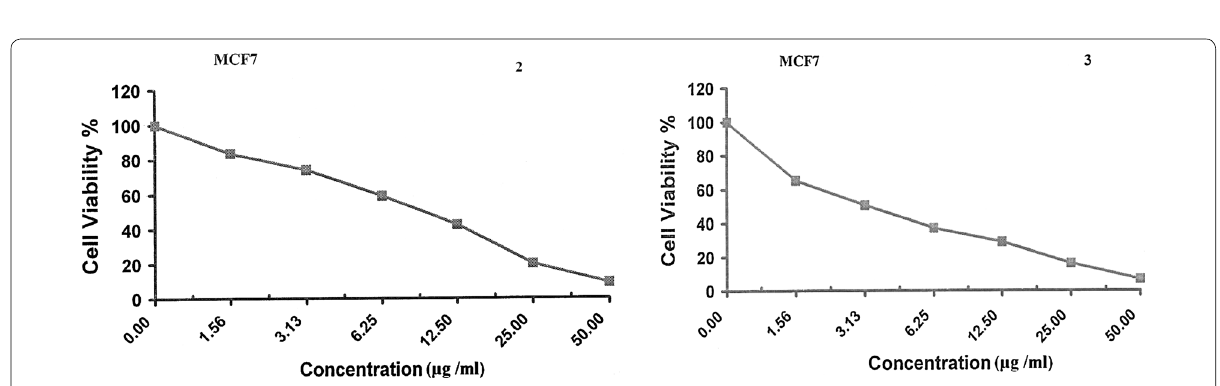
Fig. 3 Viability values of quinazoline derivatives 1 – 3 and Vinblastine sulfate against MCF 7 cell